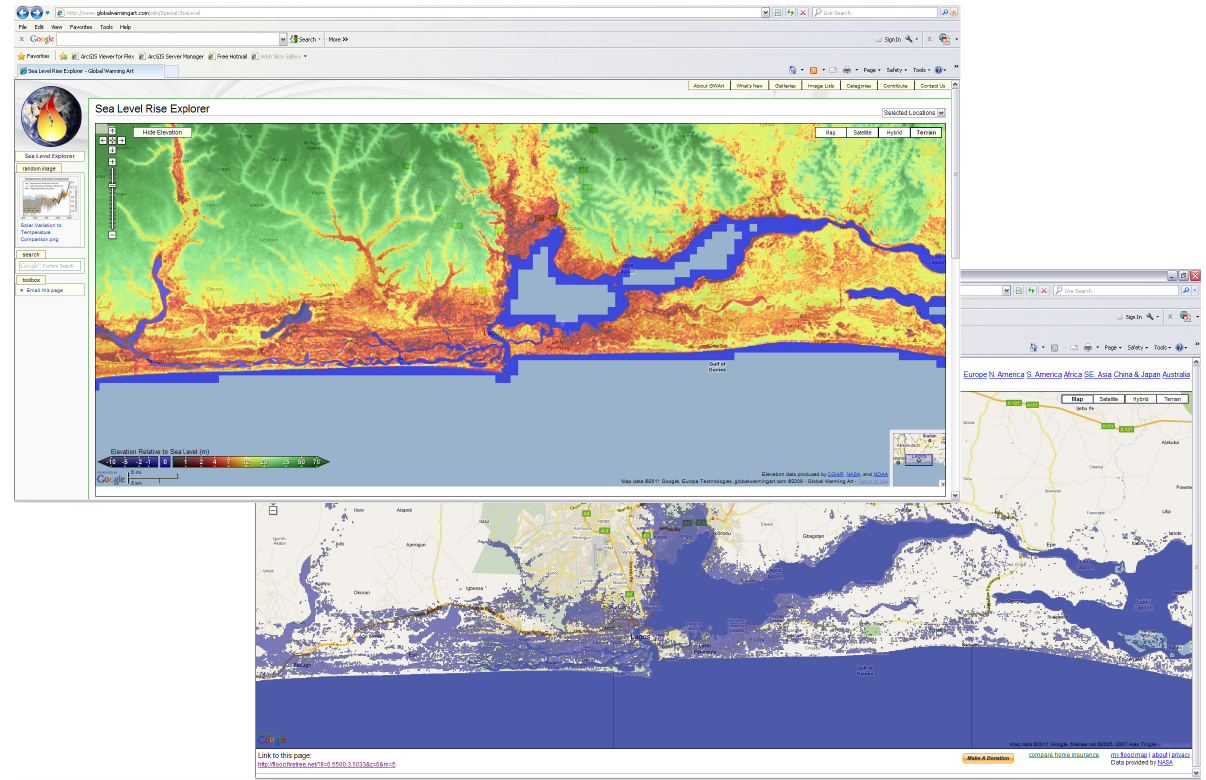
Figure 1. Online tools are available to estimate the impact of sea-level-rise on land area; tools which are based on public Digital Elevation Models (DEMs). Views were zoomed to Lagos State area. Source of upper left image: Wikipedia Sea Level Rise Explorer [6]; source of lower right image: Flood Maps